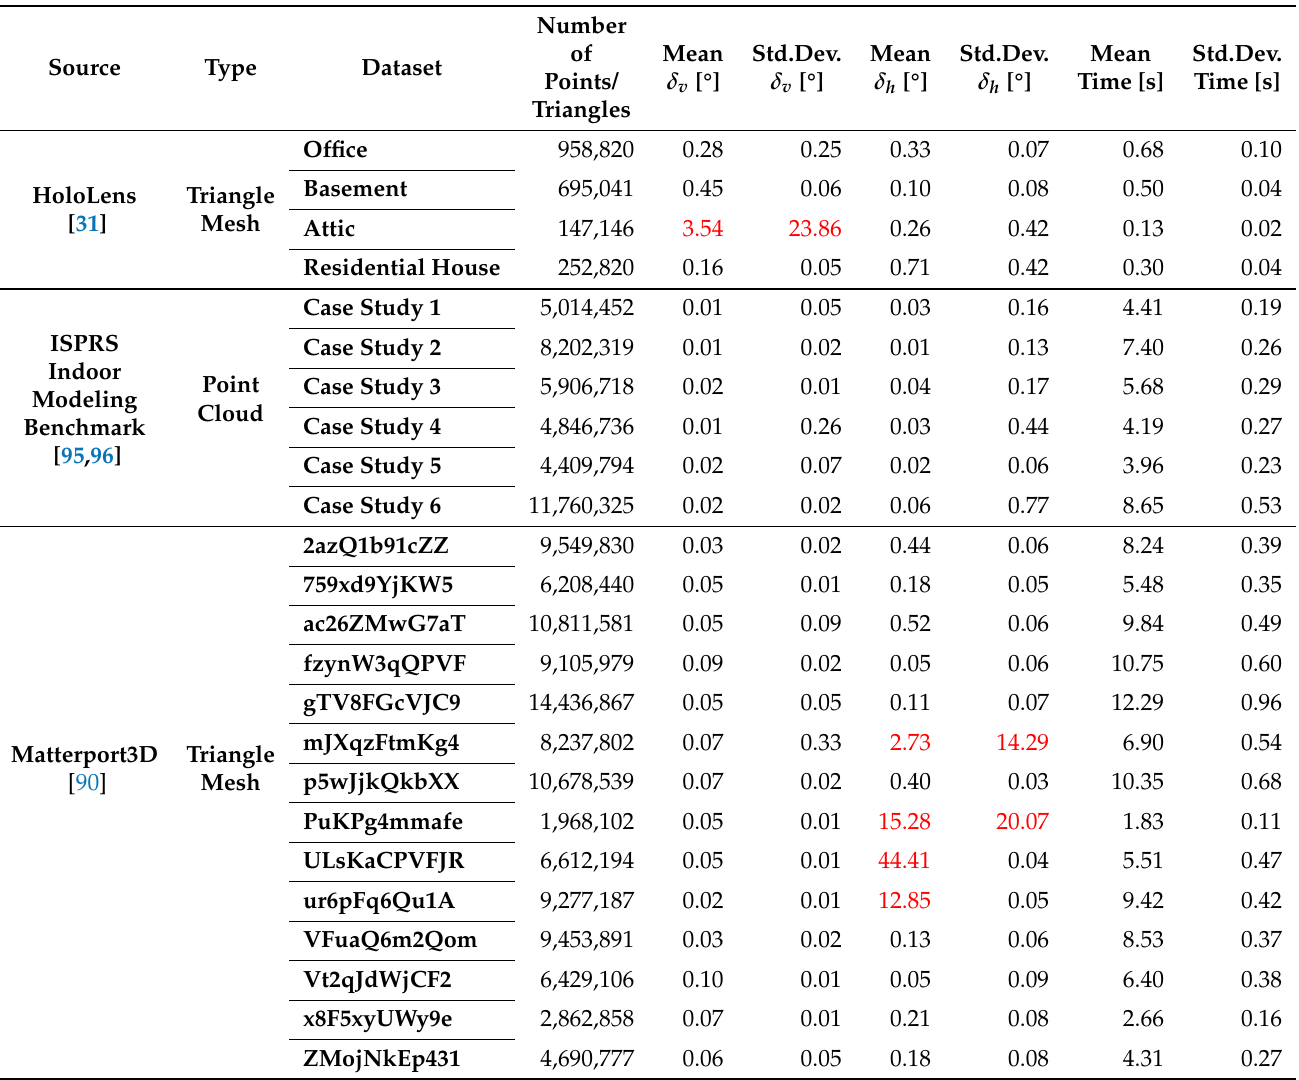
Table 1. Evaluation results for the datasets presented in Figures 12, 13 and 15. The presented values represent 50 randomly chosen orientations per dataset within the range of [ − 180°,180° ) for rotations around the vertical axis and [ − 30°,30° ] for rotations around the horizontal axes. The reported numbers of points for the point clouds of the ISPRS Indoor Modeling Benchmark refer to point clouds downsampled to a resolution of 2cm as used in this evaluation. The values marked in red are discussed in more detail in Section